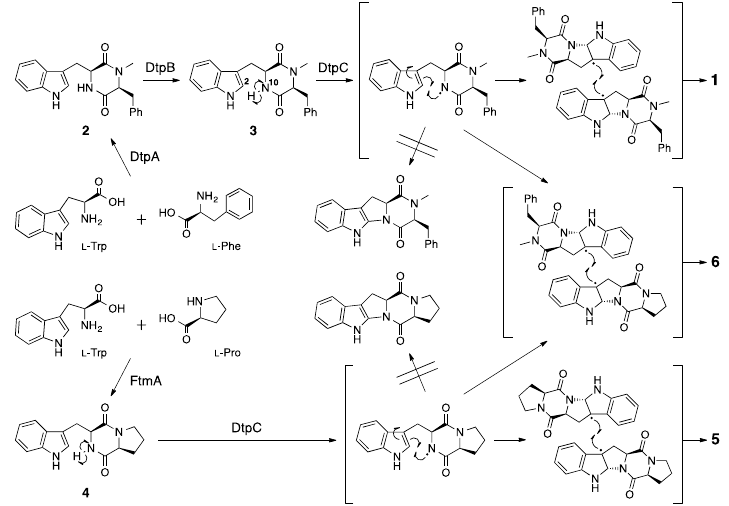
Figure 4. Proposed mechanism of DtpC-catalyzed dimerization of intermediates 3 and 4 to form ( − )-ditryptophenaline 1 , ( − )-dibrevianamide F 5 and ( − )-tryprophenaline 6 via a radical route [9]. DtpA, ditryptophenaline nonribosomal peptide synthetase (NRPS); DtpB, N -methyltransferase;